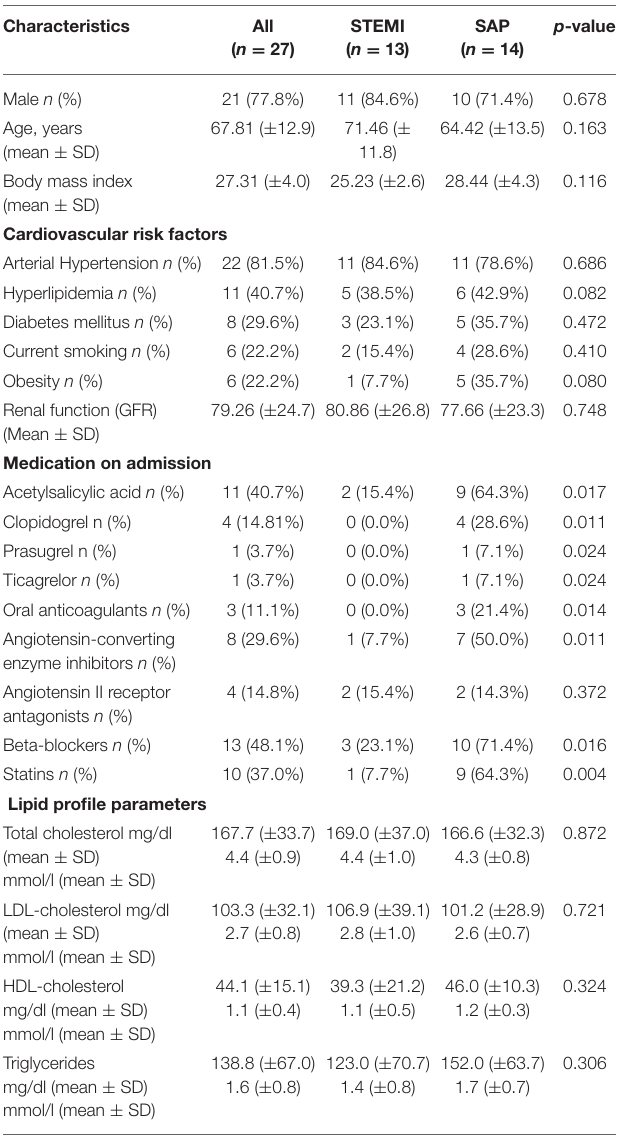
TABLE 1 | Patient demographics, cardiovascular risk factors, medication on admission and lipid profile parameters in those with STEMI and SAP.